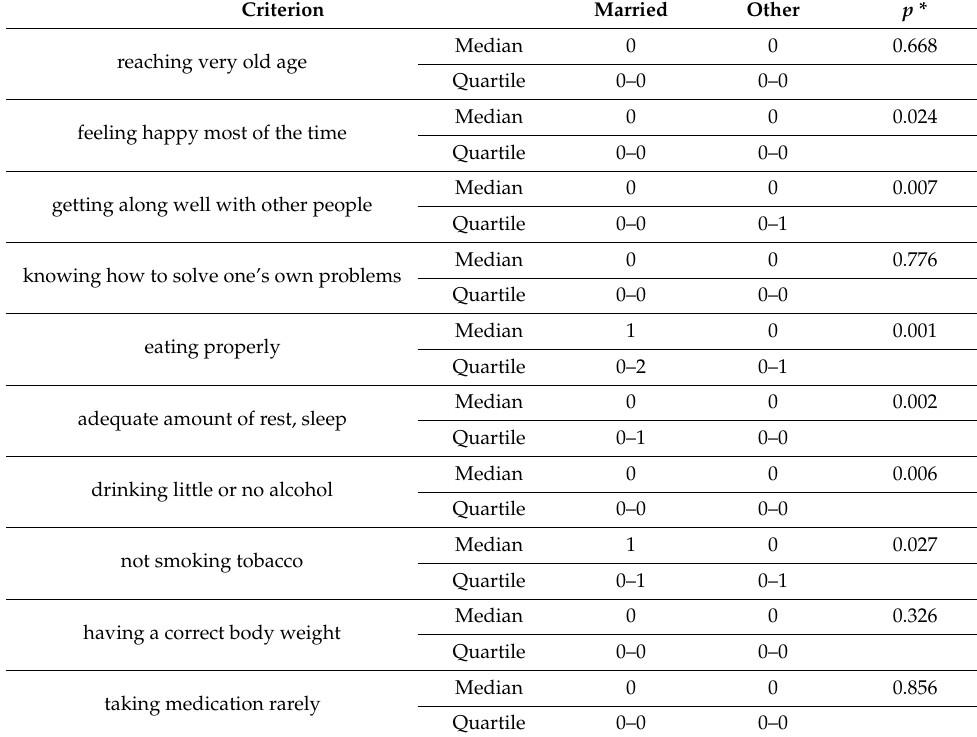
Table 9. Correlations of health statements with the marital status of the